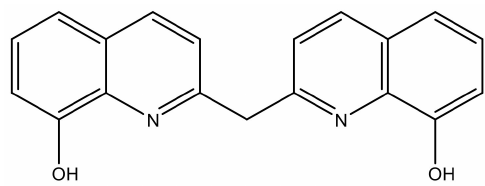
Figure 3. Tetradentate ligand designed by Dereave et al.